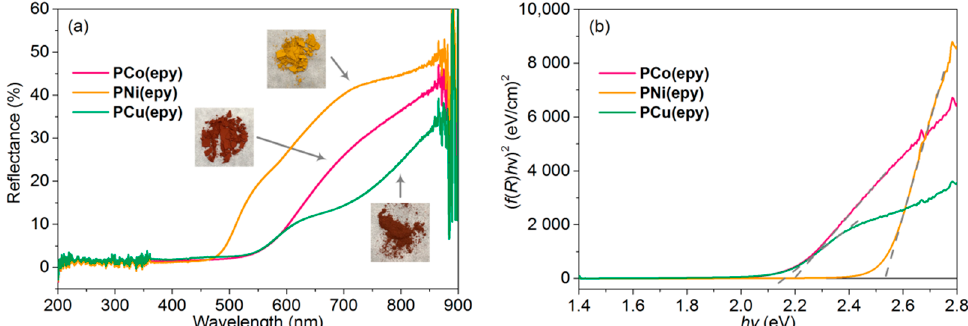
Figure 8. ( a ) UV-Vis diffused reflection spectra of neat PM(epy) powders. Inset: the photos of each sample taken under daylight. ( b ) The Kubelka–Monk function versus energy plots of the metallo-polymers.